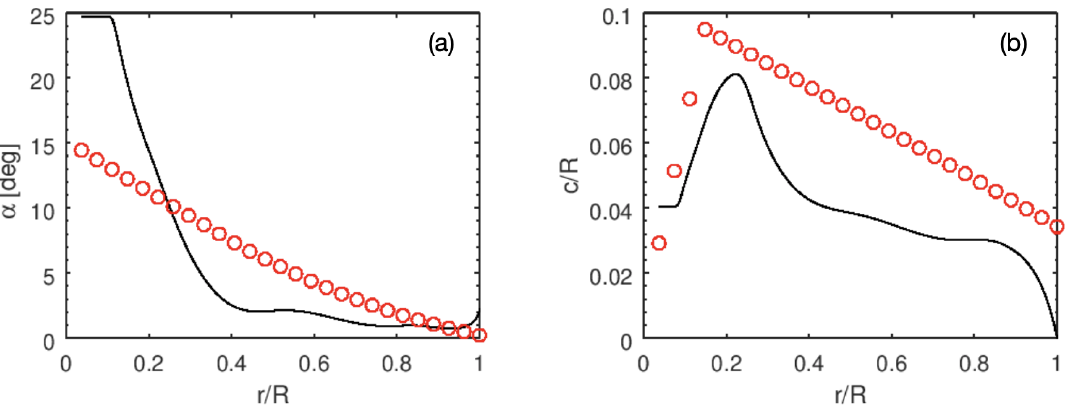
Figure 2. Radial distributions of ( a ) twist angle and ( b ) chord length. The twist angle and the normalized chord length are the same for turbines T80 and T27. Black lines: the employed turbine design; Red circle: SWiFT turbine